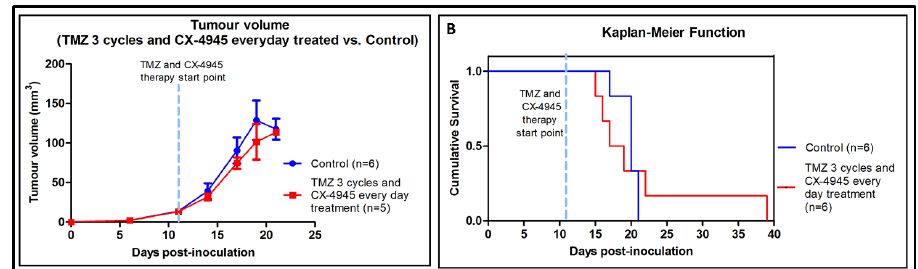
Figure 5. Tumour volume and Kaplan-Meier survival curve of mice treated with TMZ combined with CX-4945; ( A ) Tumour volumes (recorded at days 6, 11, 14, 17, 19 and 21 p.i.) of control GL261 implanted mice ( n = 6, blue line) and combined TMZ-CX-4945 cycles in GL261 implanted mice ( n = 5, red line). The dashed blue line indicates TMZ and CX-4945 therapy start point. No significant differences